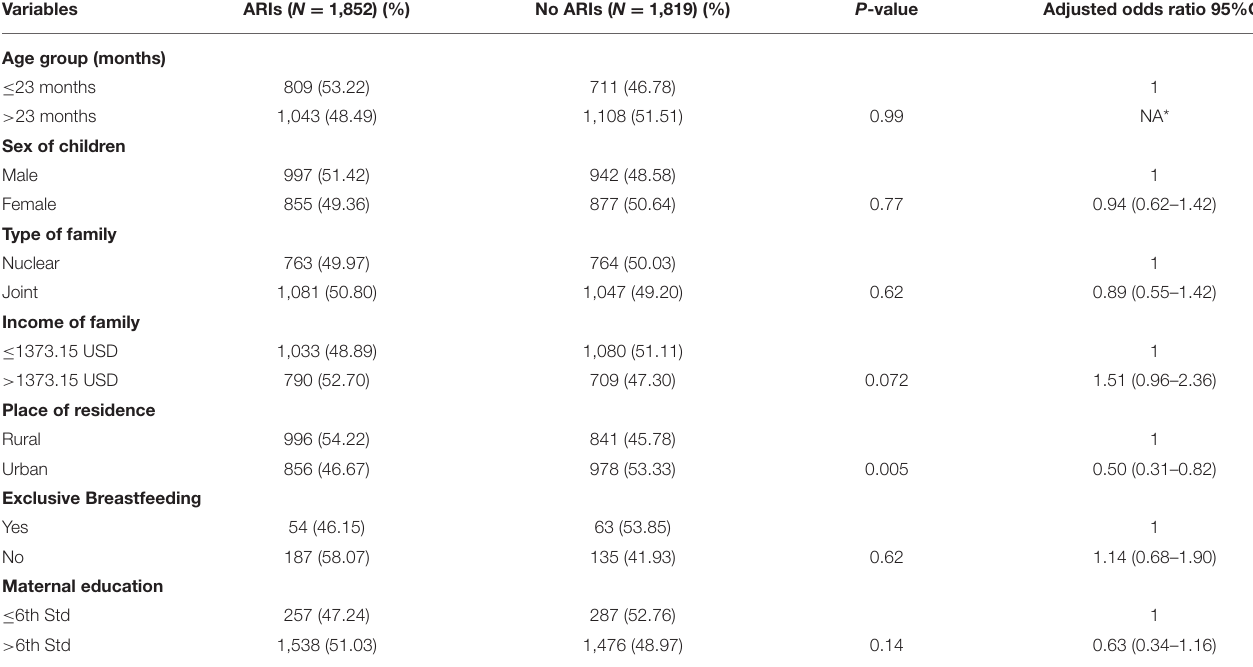
TABLE 1 | Distribution of the children with acute respiratory infection (ARI) according to the sociodemographic factors. Variables